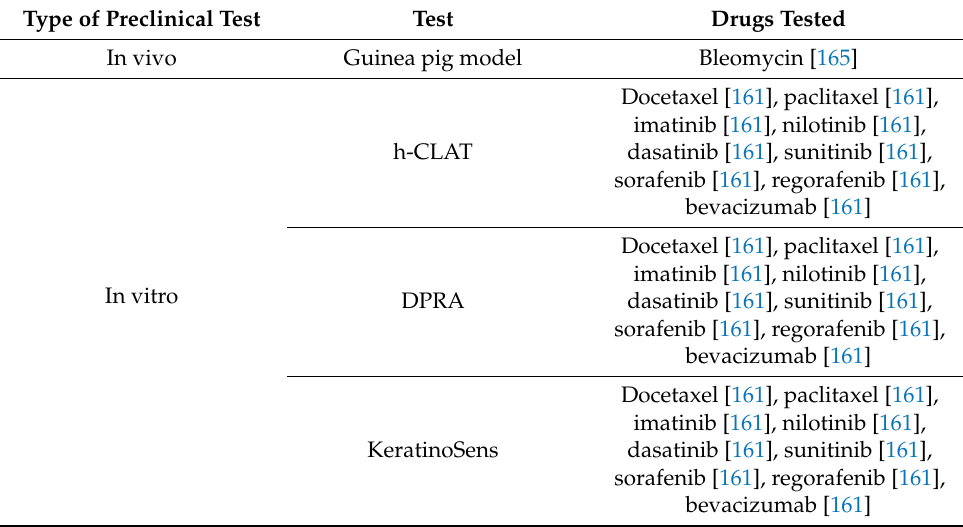
Table 4. Antineoplastic drugs tested with the in vitro or in vivo preclinical assays. Type of Preclinical